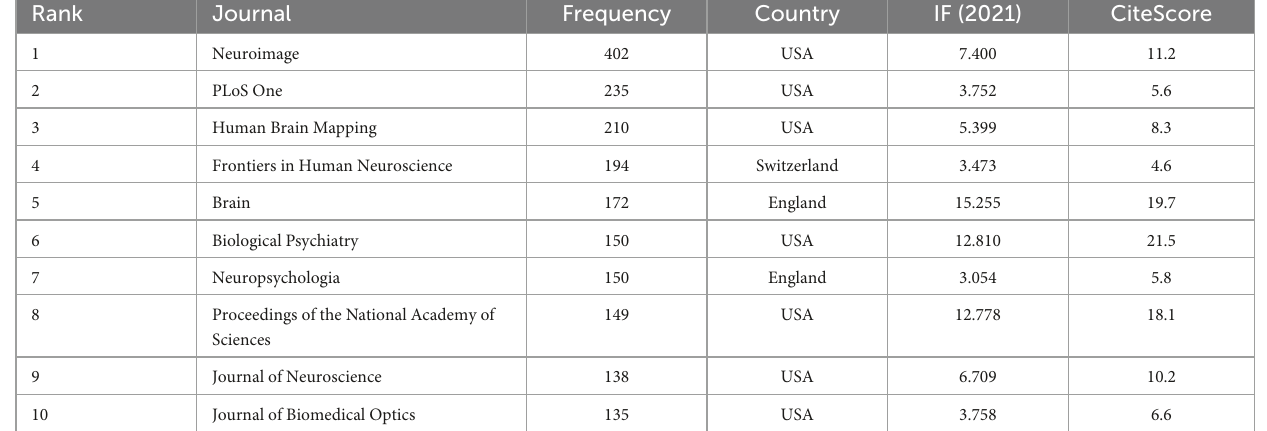
TABLE 2 The top 10 co-cited journals for functional near-infrared spectroscopy (fNIRS) research on diseases. Rank